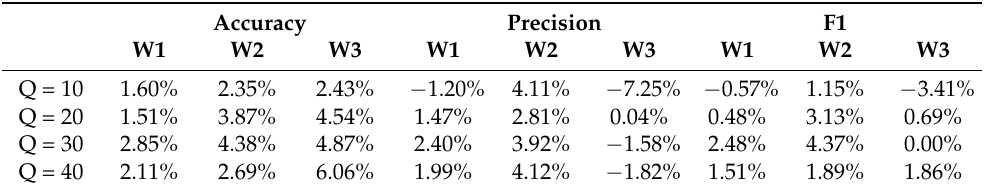
Table 6. Average difference in percentage of the customized models’ accuracy, precision and F1, considering all dataset balance cases of Sections